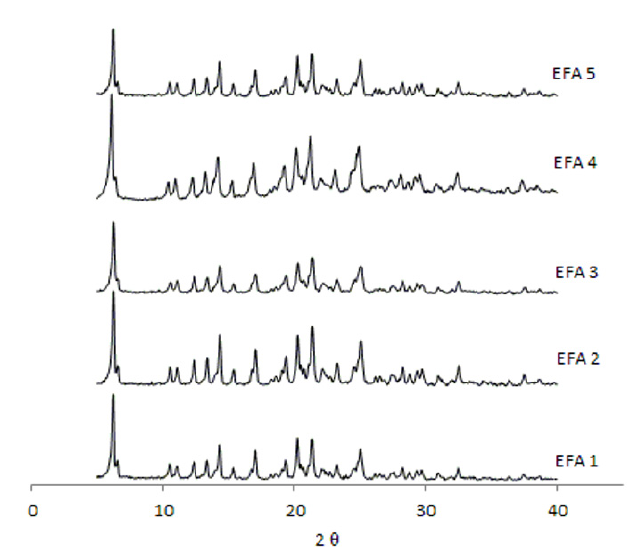
Figure 4 . Diffraction patterns obtained from the efavirenz batches 1 to 5 (EFA 1 to